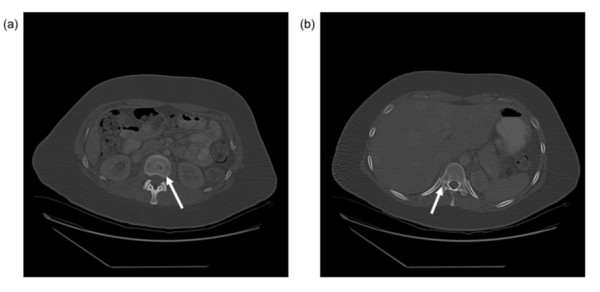
Representative magnetic resonance image revealing bone metastasis indicated by the white arrow.